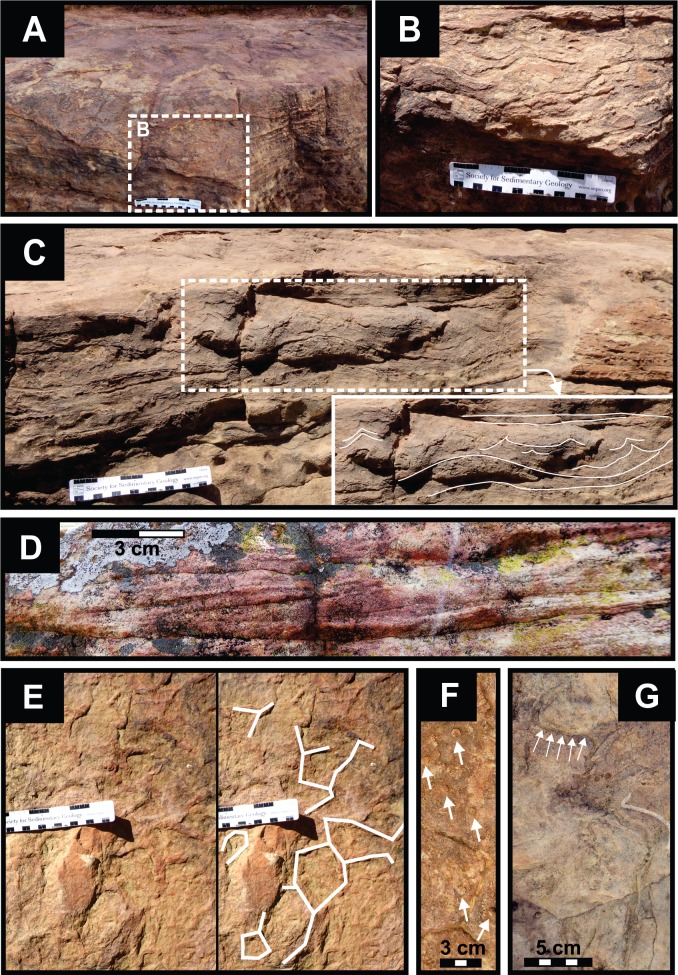
Sedimentary structures in the very fine grained sandstone host rock.(A) Close up of the horizontally laminated sandstone and its imprinted upper bedding surface (for position of B, see white rectangle). (B) Soft sediment deformation structures are common, especially close to the upper bedding plane. (C) Vertical section showing soft sediment deformation directly beneath depressions on the upper bedding plane of the horizontally laminated sandstoneare interpreted as deformation related to the loading effect by dinosaur foot. White rectangle marks the position of the inset with undertrack deformation (deformations marked in white). (D) Low-angle cross-bedding is present but rare. (E) Hexagonal casts of desiccation cracks on the exposed track palaeosurface have an angular, box-shaped cross-section (right image same as left, but shows interpretation of mud crack structures). Note that these are larger crack fillings than those within the tracks (e.g., Figs. 5A and 7C). (F) Vertical invertebrate burrows on bedding planes present as circular pits that are ∼0.6 cm in diameter. White arrows mark the traces. (G) Non-branching, unlined, unornamented, slightly curving to straight, horizontal, cylindrical burrows of invertebrates are filled with massive, very fine grained sandstone. White arrows mark the traces that have a constant diameter along their length.